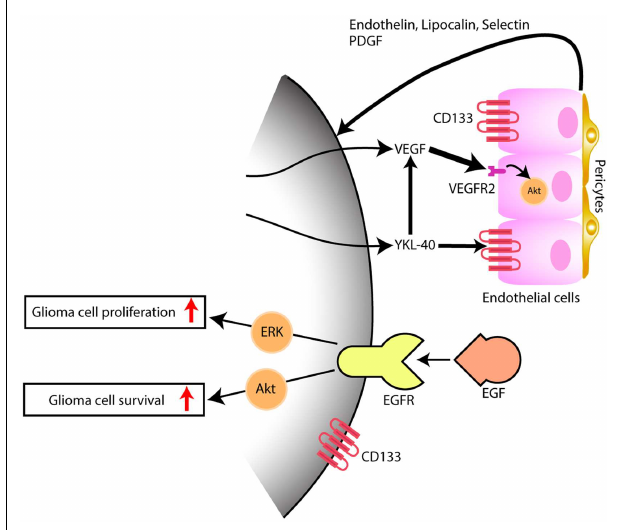
FIGURE 1 | Model depicting the interaction of tumor cells within the microenvironment, predominantly with endothelial cells .While EGFR has been thoroughly and the most well studied and yet, not successful target signaling cascade in gliomas,YKL-40 may also promote glioma proliferation and survival, by inducing angiogenesis, throughVEGF upregulation (thick arrow) and byVEGF-independent pathways (thin arrow), after persistent blockade ofVEGF. Hypothetical, in aVEGF independent mechanism,YKL-40 secreted by the glioma cell modulates upon activation of CD133 + endothelial cells, the expression of endothelial-derived factors that are capable of triggering tumor angiogenesis and feedback to glioma cells, some of which also express the stem cell marker CD133 + , promoting tumor